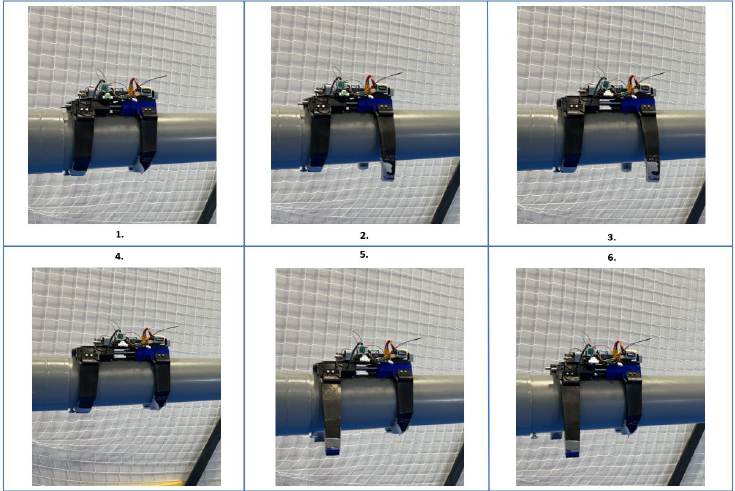
Figure 8. Example of movement sequence of the soft landing gear: (in stage one ), it grips to the pipe; (in stage two ), it opens the front limbs (blue case); (in stage three ), it moves forward; (in stage four ), it closes the front limb (blue case); (in stage five ), it opens the rear limbs (black case); and finally, (in stage six ), it moves the rear